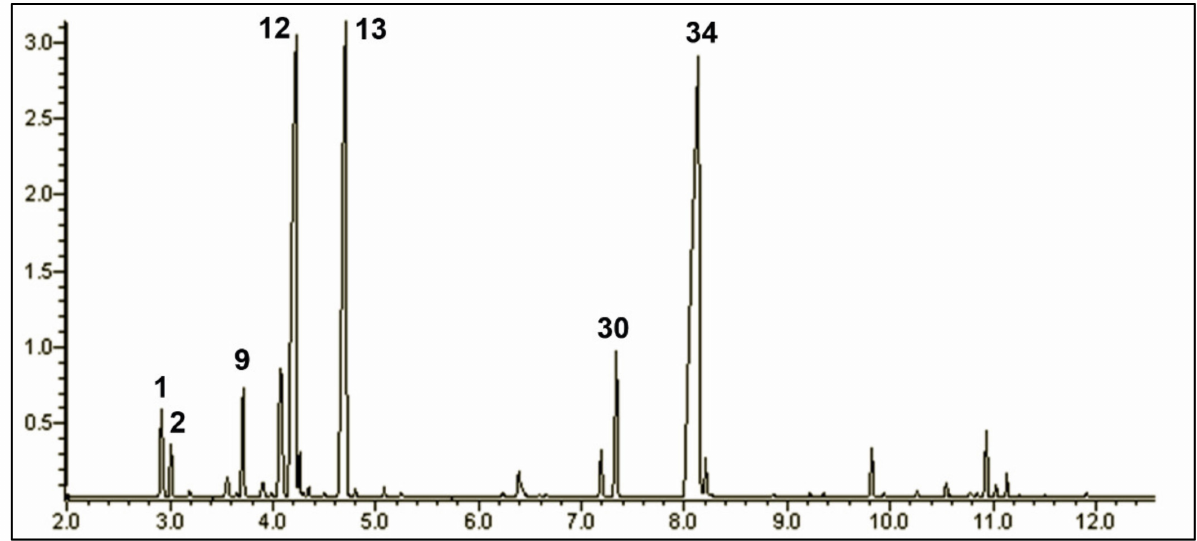
Figure 1. Gas chromatography–mass spectrometry (GC-MS) profile of the Origanum vulgare spp. hyrtum essential oil (numbers refer to Table